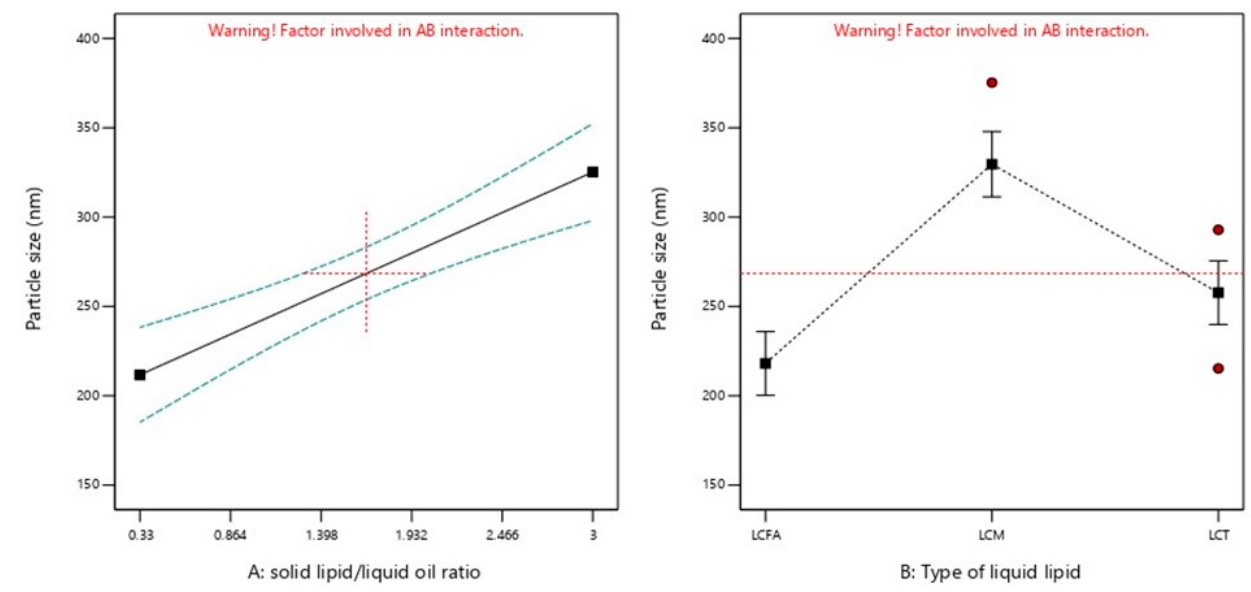
Figure 2. Graphical representation of the effects of ( A ) solid lipid: liquid oil ratio and ( B ) type of liquid oil on droplet size. Red dotted horizontal line and plus sign represent the average value over factor B at the focused point of factor A = 1.665, respectively. Green dotted lines represent 95% CI bands. Red circles and black squares represent design points and predicted values, respectively.